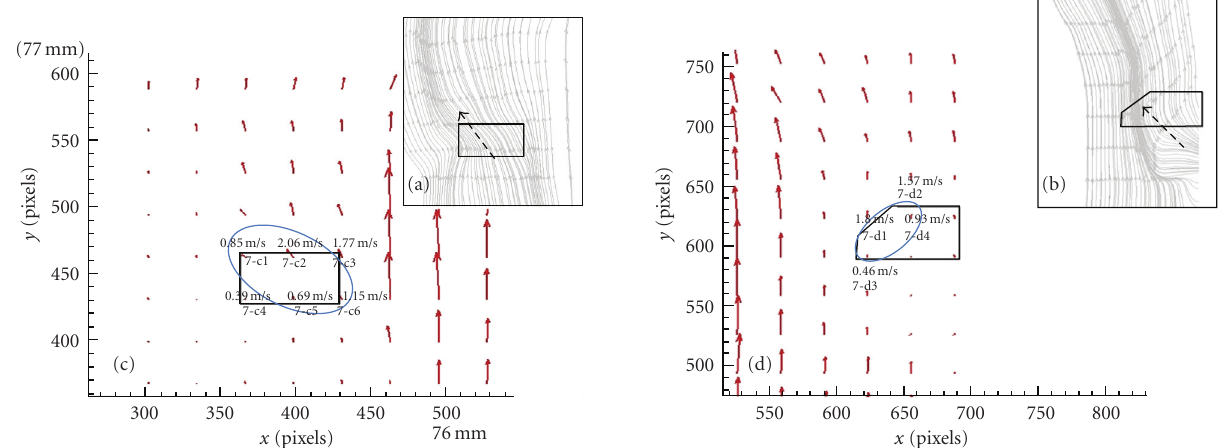
Figure 7: (a) and (b) Streamlines passing through the left (a) and right (b) flame edges of case 4. (c) Velocity variation at the left flame edge of case 4. The points’ velocities in the polygon are 0.85 m/s, 2.06 m/s, 1.77 m/s, 0.39 m/s, 0.69 m/s, and 1.15 m/s (ordered by left to right, top down). (d) Velocity variation at the right flame edge of case 4. The points’ velocities in the polygon are 0.93 m/s, 0.66 m/s, 0.46 m/s, 0.42 m/s, and 0.45 m/s (ordered by left to right, top down). The velocities of points 7-d1 and 7-d2 are 1.8 m/s and 1.57 m/s, respectively.